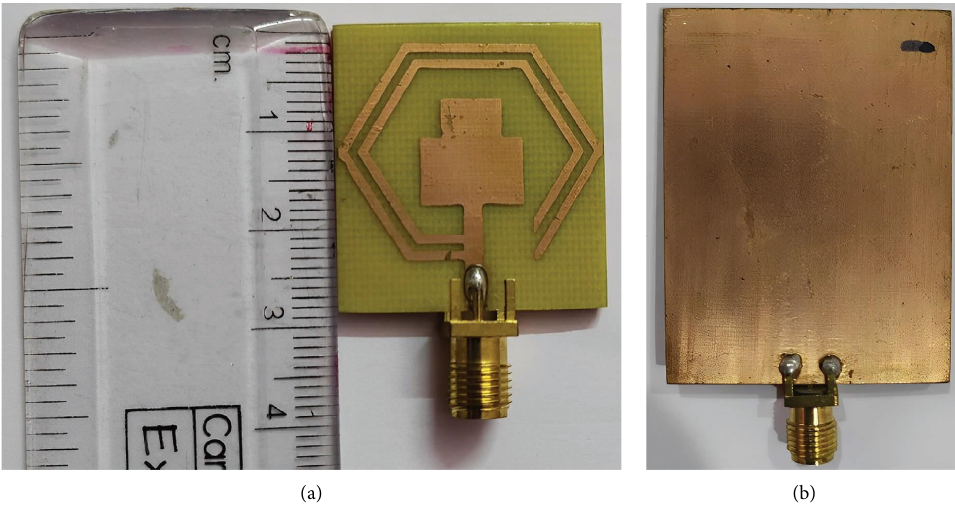
Figure 11: Front view and back view of fabricated antenna. (a) Front view. (b) Back